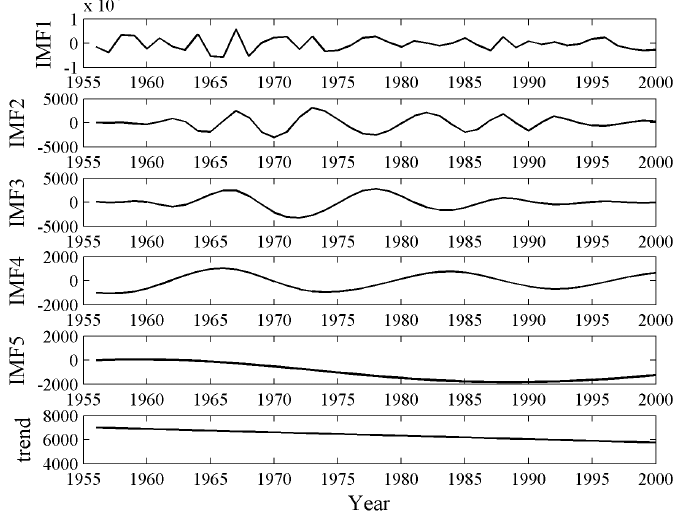
Figure 2. Empirical mode decomposition (EMD) results of runoff series for Shangjingyou station.